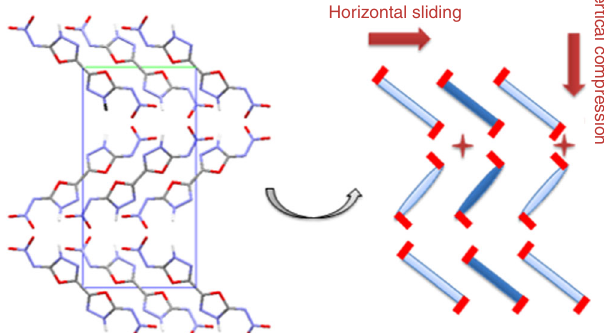
Fig. 5 Packing diagram of ICM-101. Viewed down the crystallograph from